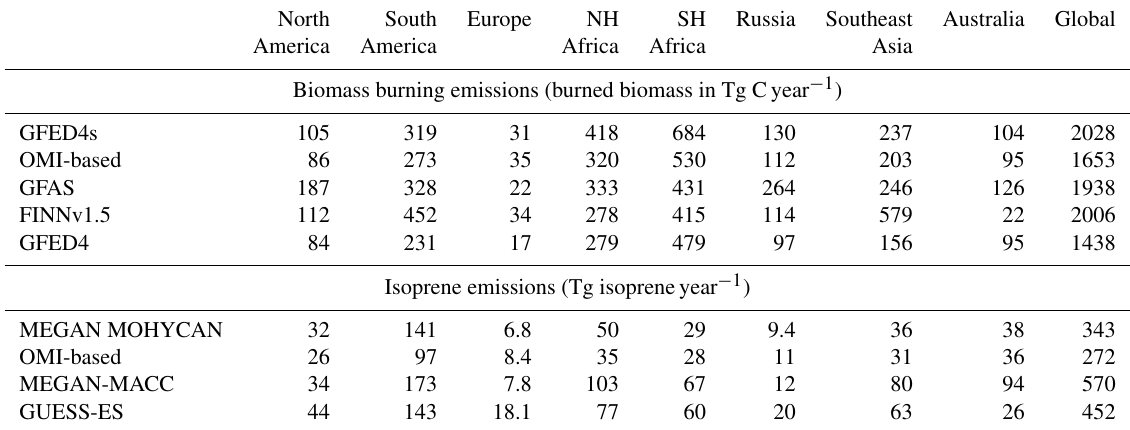
Table 1. Mean a priori and OMI-based emission estimates compared to independent emission inventories for open biomass burning and isoprene emissions calculated for different world regions and globally. Regions are defined in Fig. 3. The means are taken over the period of data availability, i.e., over 2005–2013 for all inventories, except for MEGAN-MACC (2005–2010) and GUESS-ES (2005–2009). NH: Northern Hemisphere; SH: Southern Hemisphere.